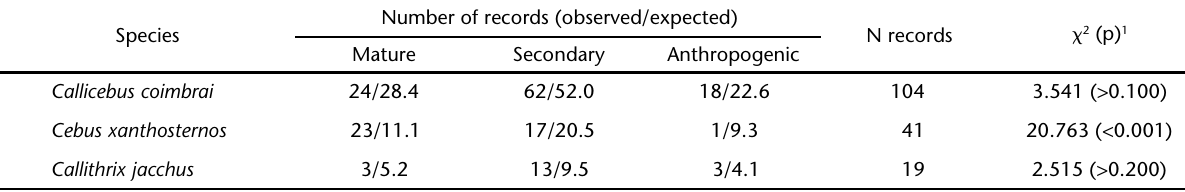
Table III. Comparison of the number of sightings recorded (observed) and expected for each of the three primate species at the Fazenda Trapsa, according to the availability of different habitats.